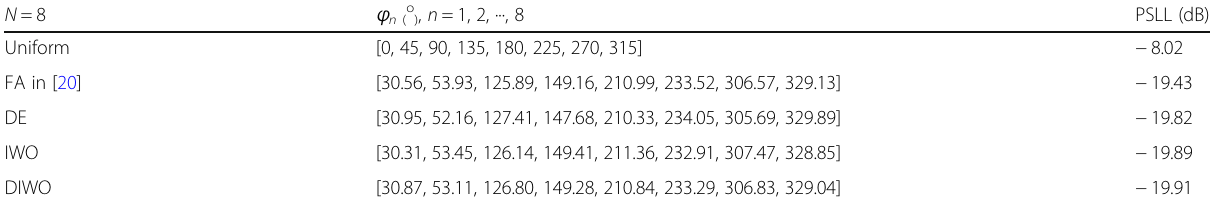
Table 2 Positions of elliptical antenna array with 8 elements